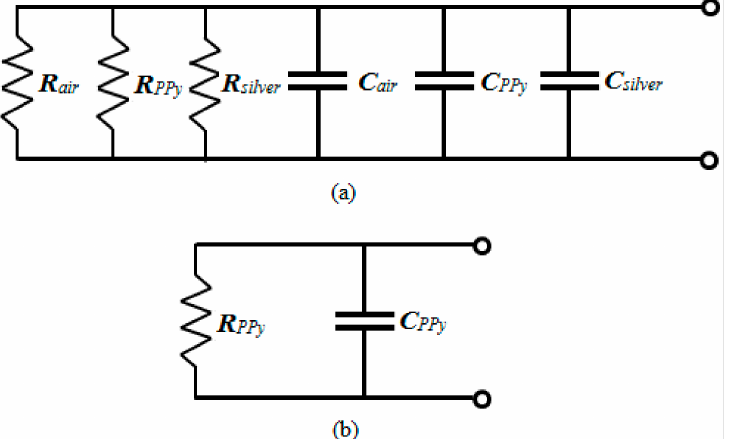
Figure 11. ( a ) Detailed schematic diagram of electrical equivalent circuit of Ppy composite thin film sensor and ( b ) simplified schematic diagram of electrical equivalent circuit of Ppy composite thin film